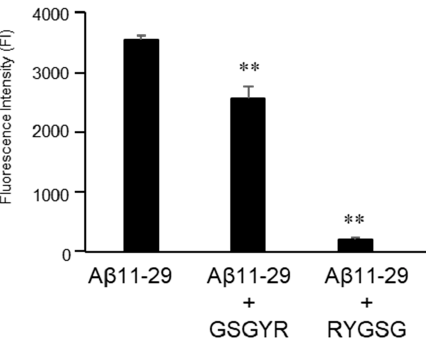
Figure 4. Effect of GSGYR and RYGSG on aggregation of A β 11-29. Data are presented as mean ± SEM. n = 3. ** indicates p < 0.01 versus A β 11-29. n = 3. ** indicates p < 0.01 versus A β